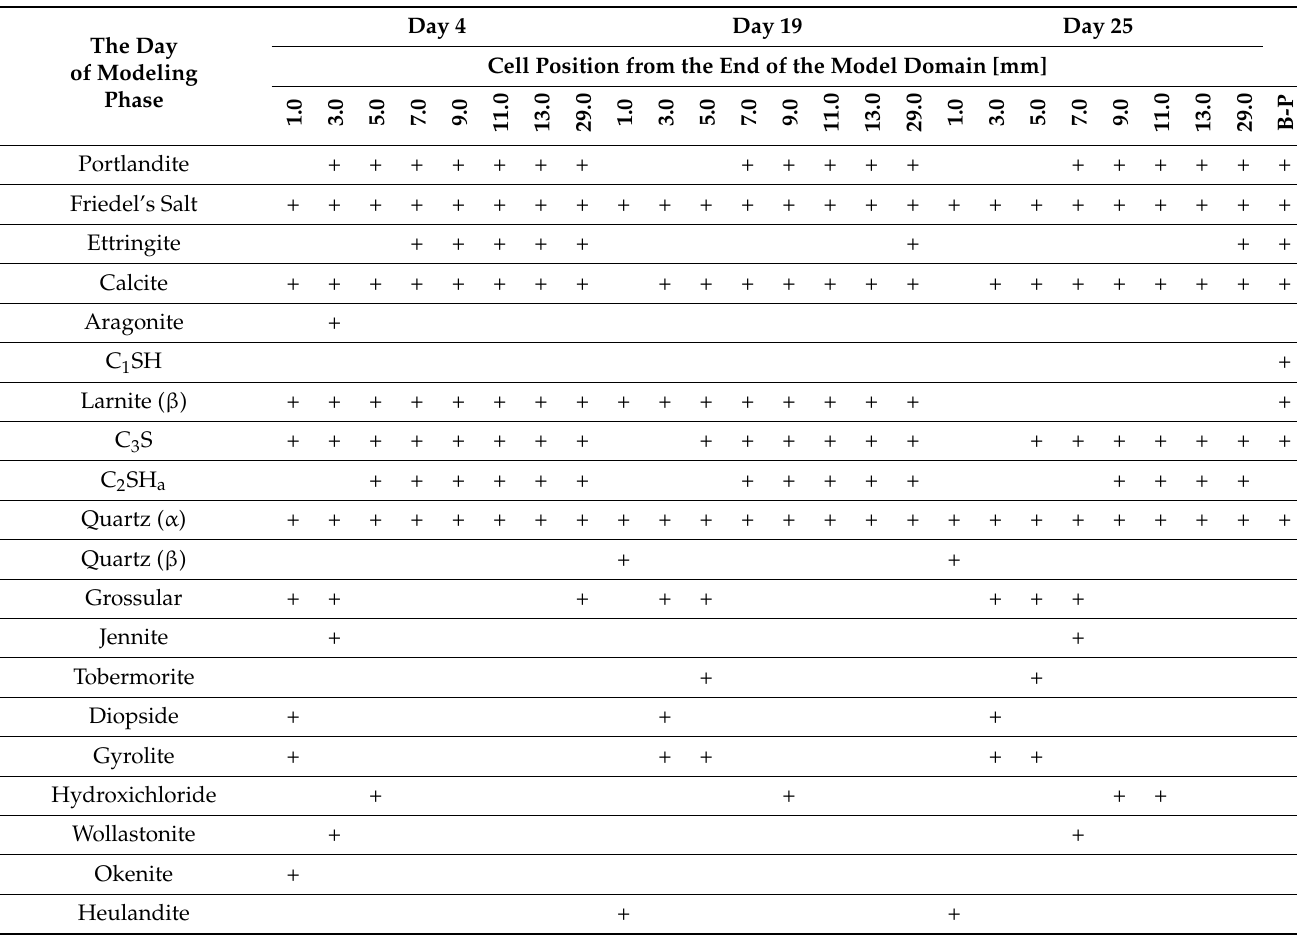
Table 7. Occurrence of mineral phases in successive cells of the model, identified on the basis of simulation (B-P—reference sample), ( + in table means that phase was present in a